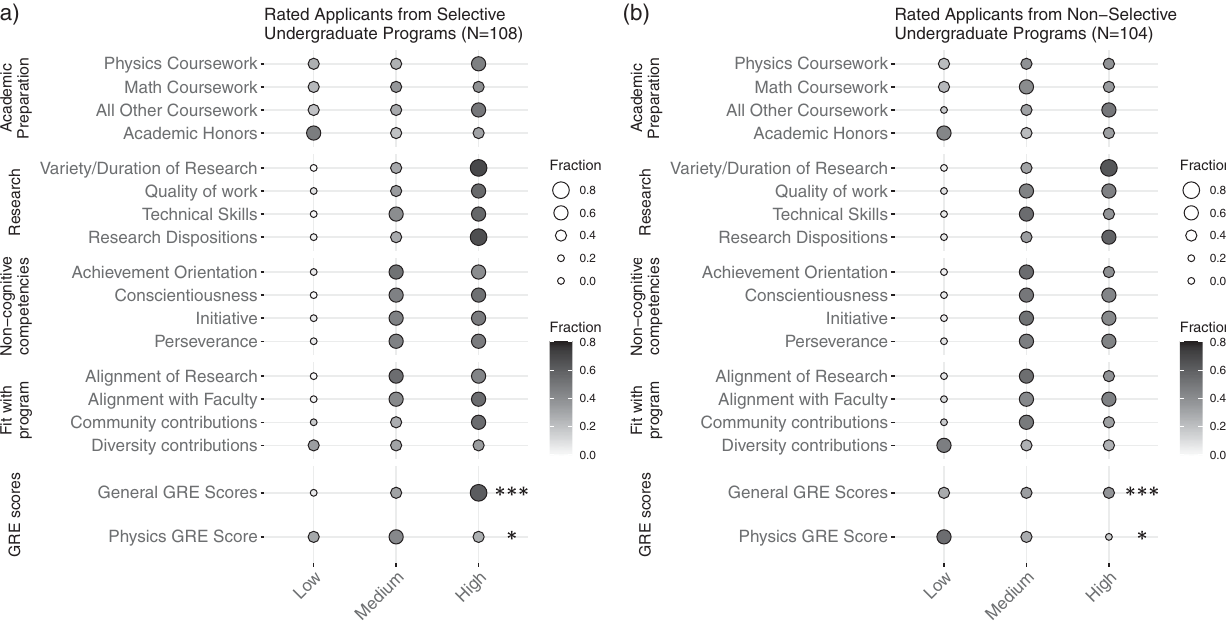
FIG. 4. Faculty ratings of domestic applicants (admitted and nonadmitted) on 18 constructs split by whether the applicant attended a more selective or less selective undergraduate university. Ratings that are statistically different between the two plots are marked on the right side of the plot, with a corrected p value < 0 . 001 represented by ***, < 0 . 01 by **, and < 0 . 05 by *. Only the general GRE and physics GRE scores showed differences.